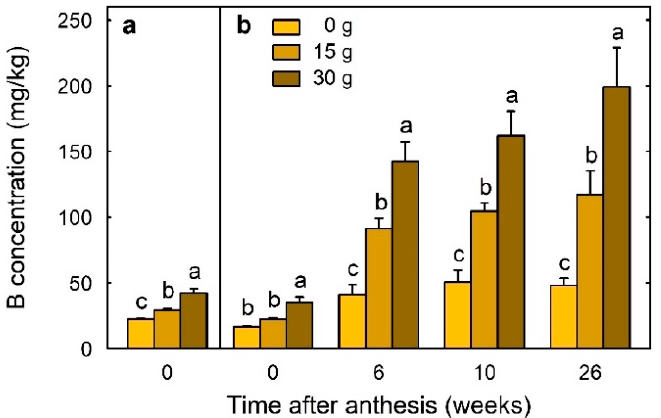
Figure 1. ( a ) Floral and ( b ) foliar boron (B) concentrations of macadamia cultivar ‘816’ trees treated with 0, 15 or 30 g B prior to flowering. Means (+SE) with different letters within a time point are significantly different (generalised linear models, p < 0.05, n = 10 trees).